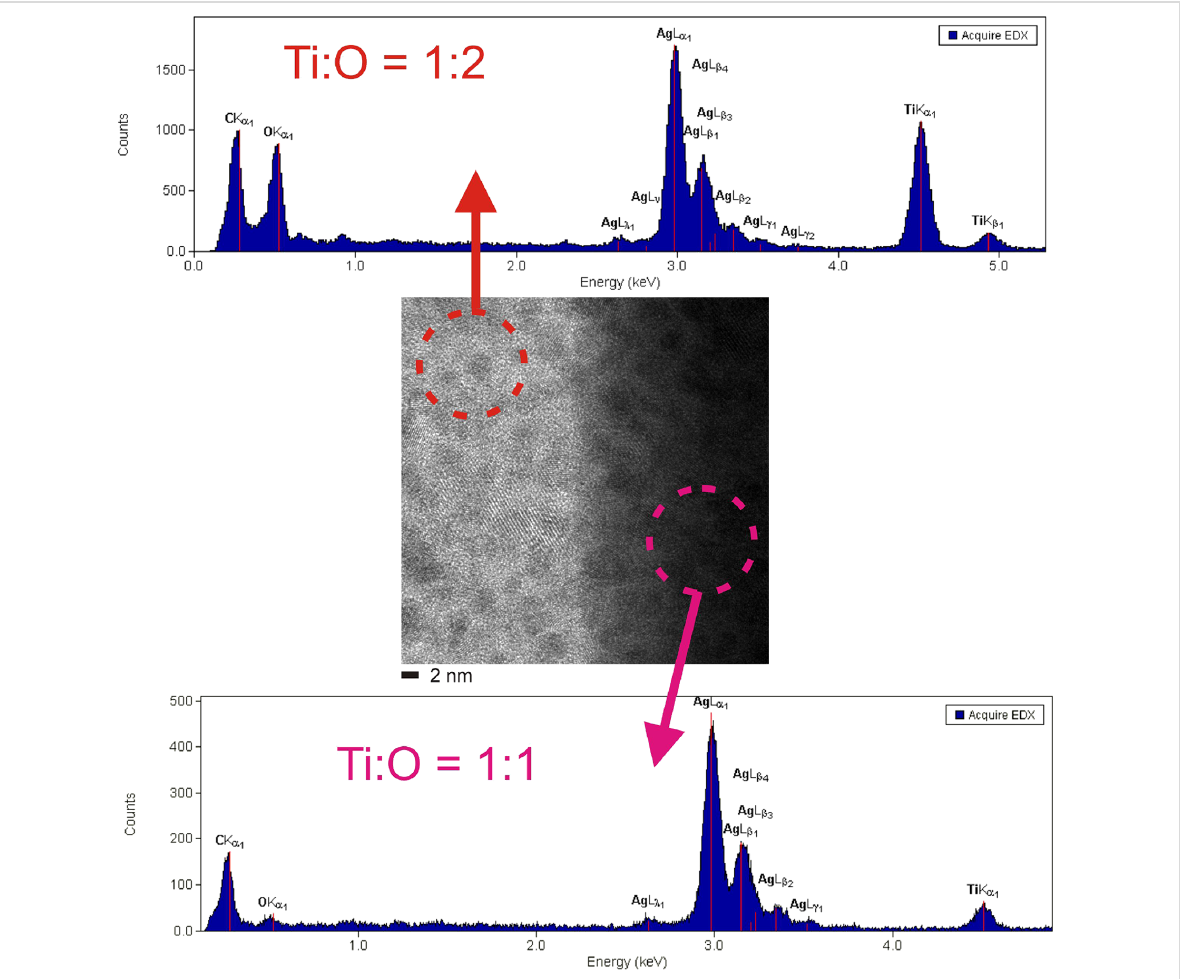
Figure 9: TEM nanoprobe EDX analysis on the TiO crystal and the matrix confirming the ratio of Ti:O in both the areas to be 1:1 and 1:2, respectively.